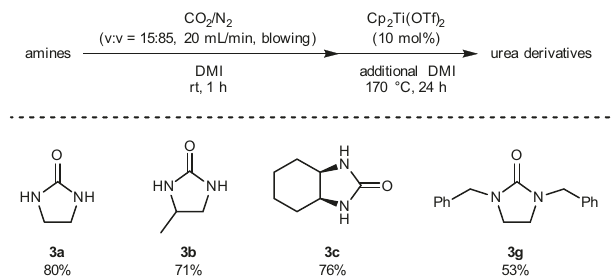
Fig. 5 Substrate scope for the one-pot synthesis of urea derivatives. Reaction conditions: amines (2.0mmol), Cp 2 Ti(OTf) 2 (0.20mmol), and DMI (2.0mL + 2.5mL), and 5mL sealed reaction vessel. Yields of urea derivatives were determined by 1 H NMR, using mesitylene as an internal